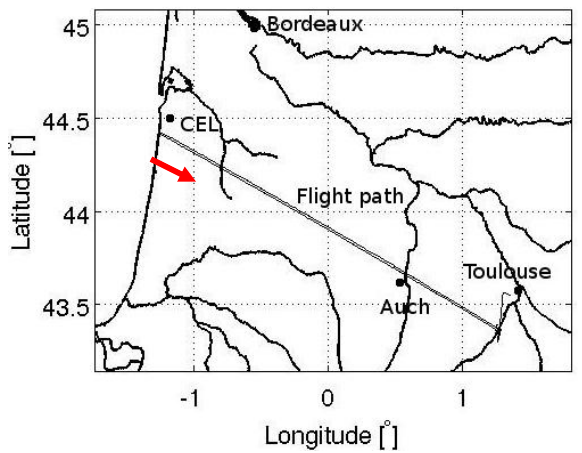
Figure 2. CAROLS flight path on 29 May 2009. The portion of the flight indicated by the red arrow was dedicated to the use of a spectrum analyzer, in combination with the CAROLS